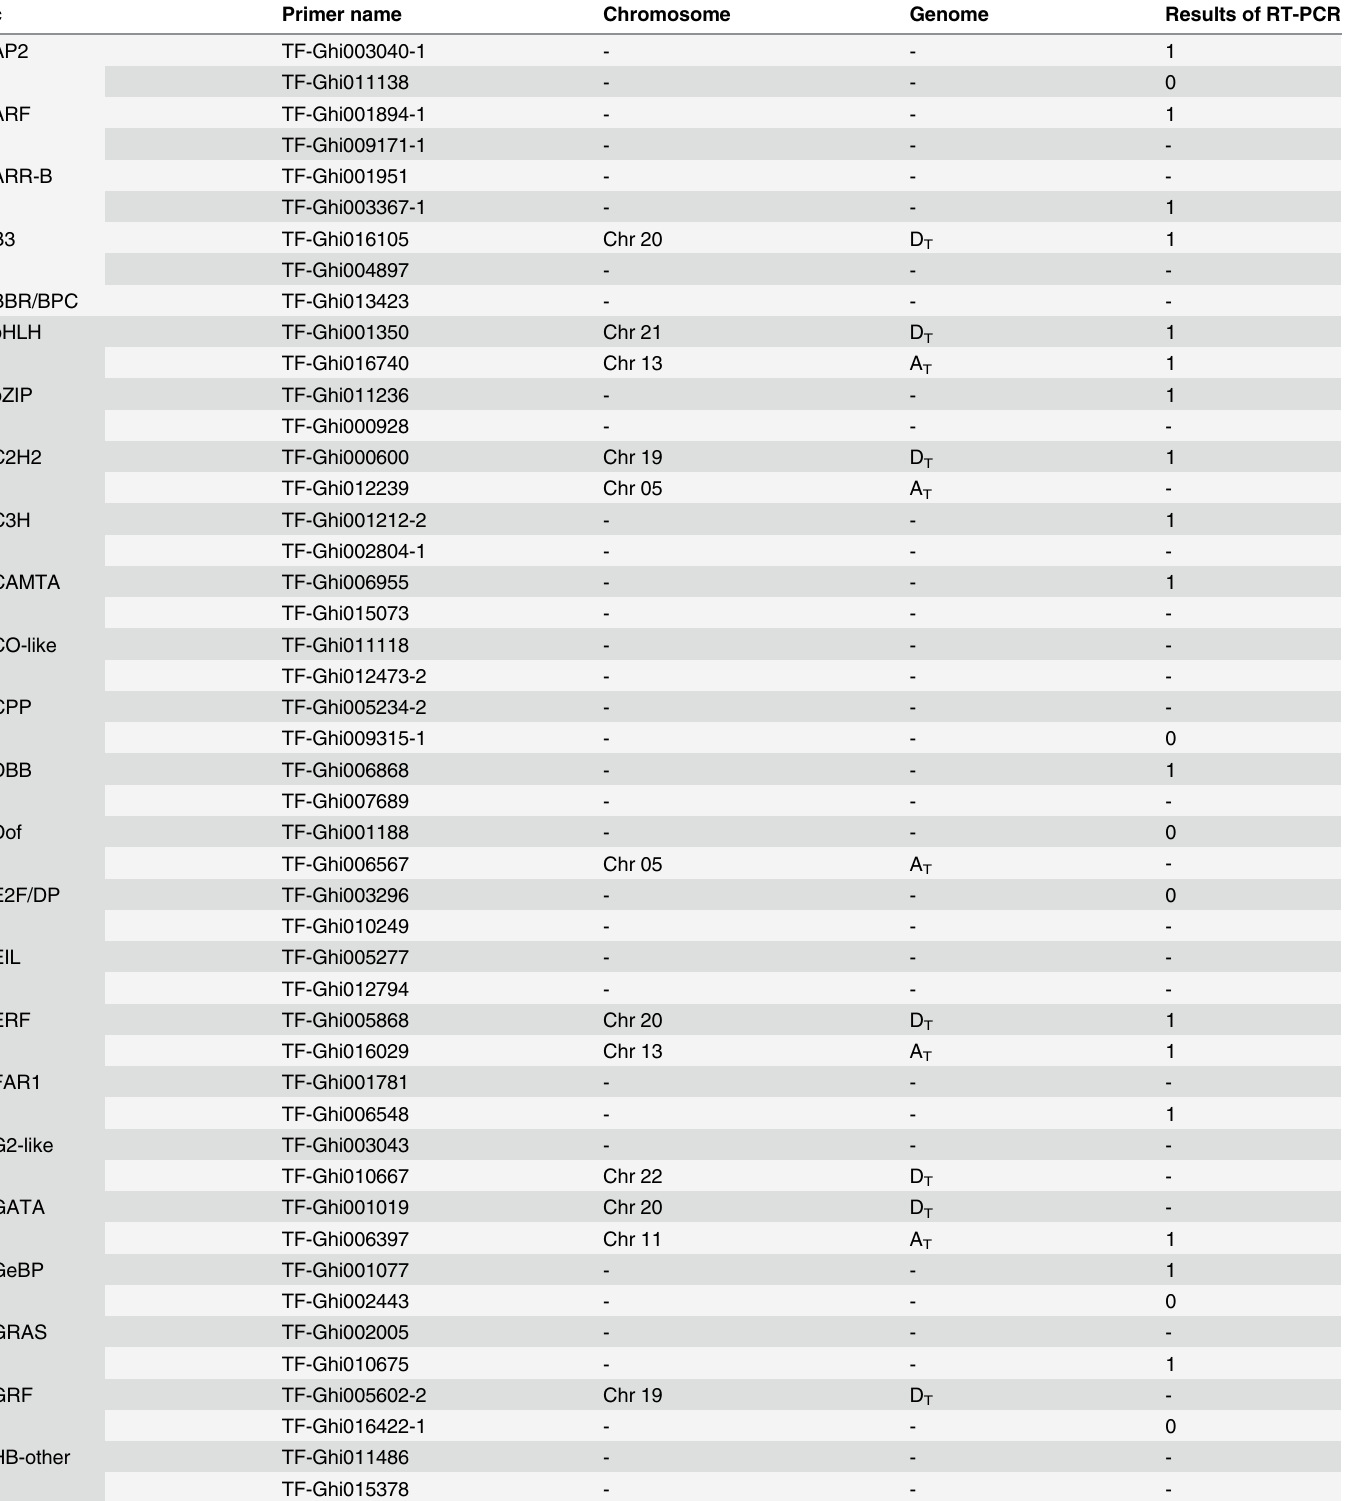
Table 2. Chromosome localization and RT-PCR analysis of